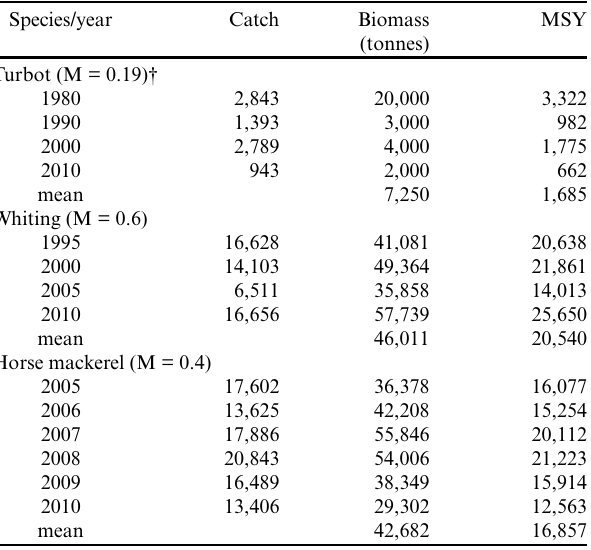
Table 3 . Application of Cadima’s formula to estimate maximum sustainable yield (MSY) of turbot, whiting, and horse mackerel stocks in the Black Sea.